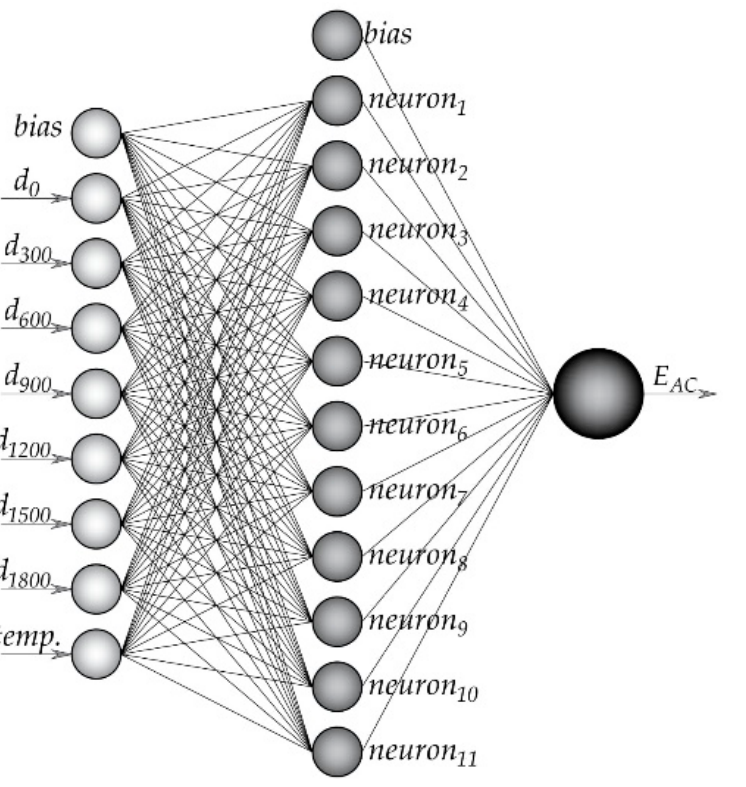
Figure 3. ANN architecture with one hidden layer.